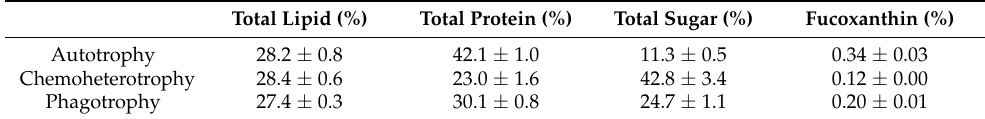
Table 1. Biochemical composition of P. malhamensis cultivated with different nutritional modes ( n =